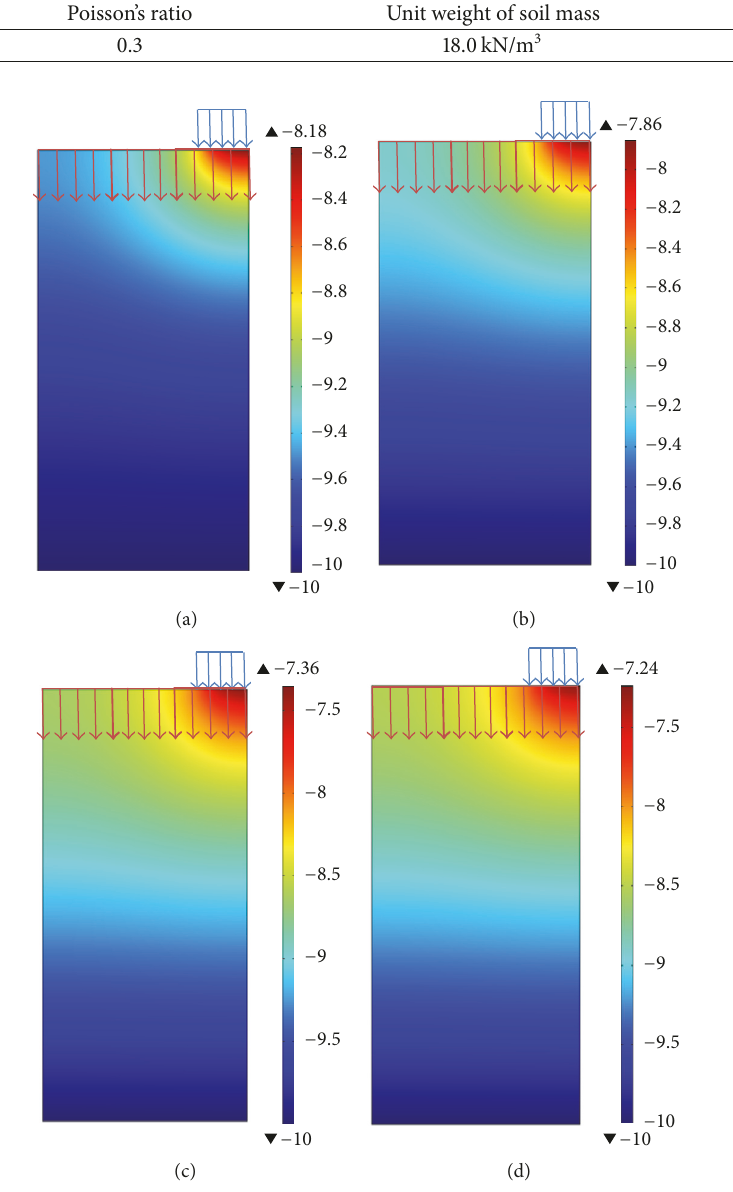
Figure 4: The pressure head profile variation with infiltration time: (a) 𝑡 = 5h; (b) 𝑡 = 10h; (c) 𝑡 = 30h; (d) 𝑡 = 50